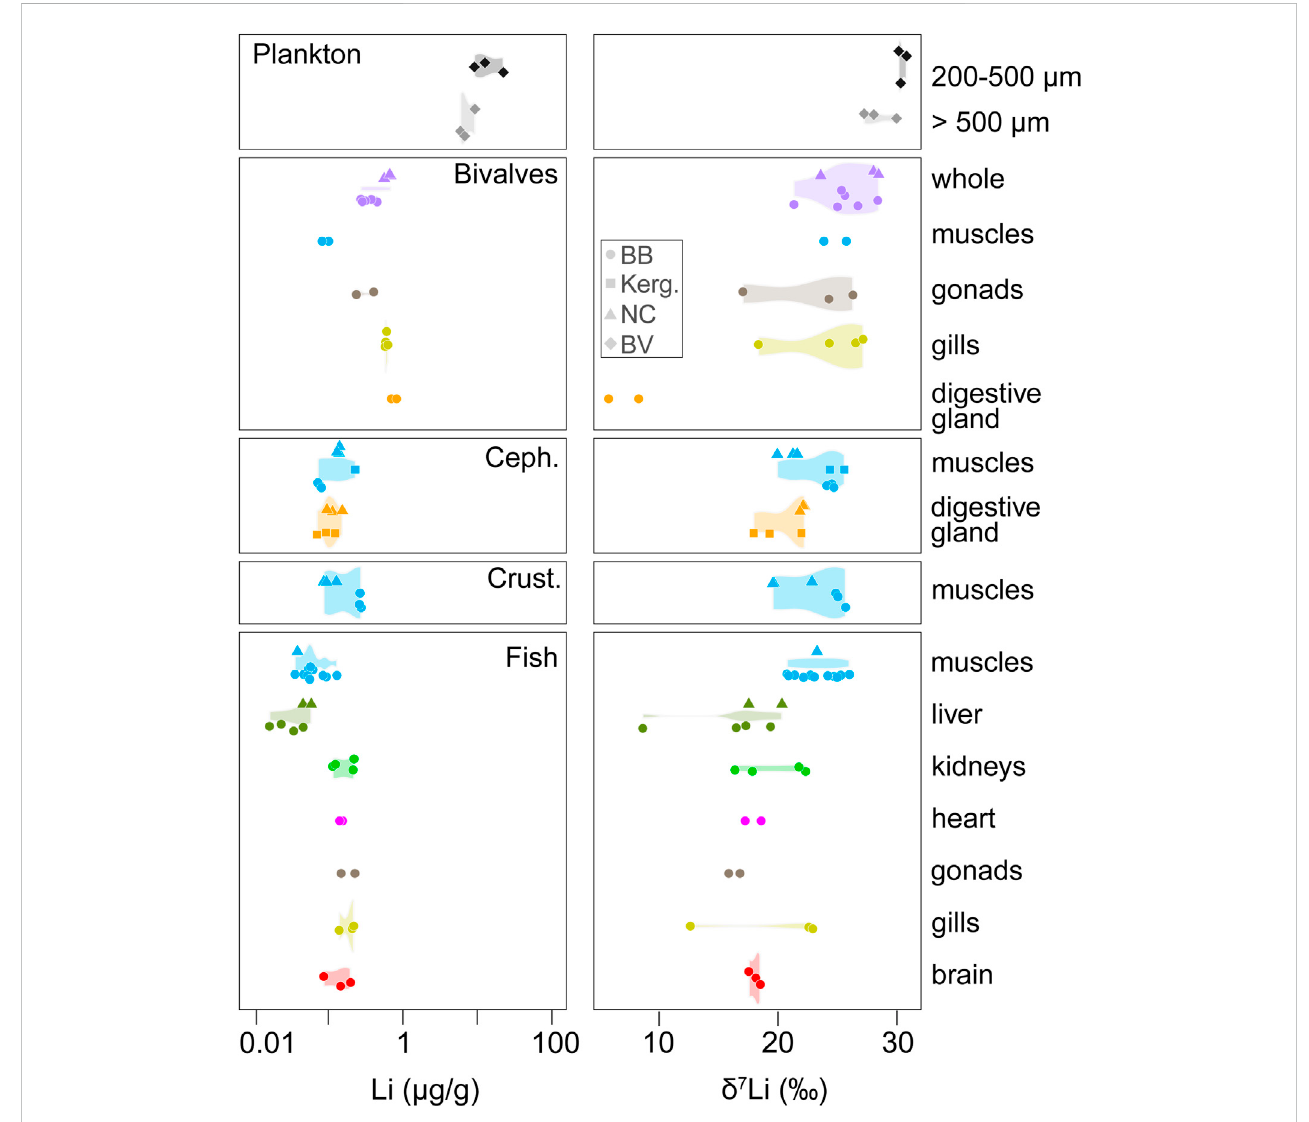
FIGURE 1 Li concentrations and Li isotope compositions measured in the whole body ( “ whole ” ) and different tissues of marine organisms. Abbreviations: Crus., crustaceans; Ceph., cephalopods. Li concentrations are from (Thibon and Weppe et al., 2021c), except for zooplankton (this study).